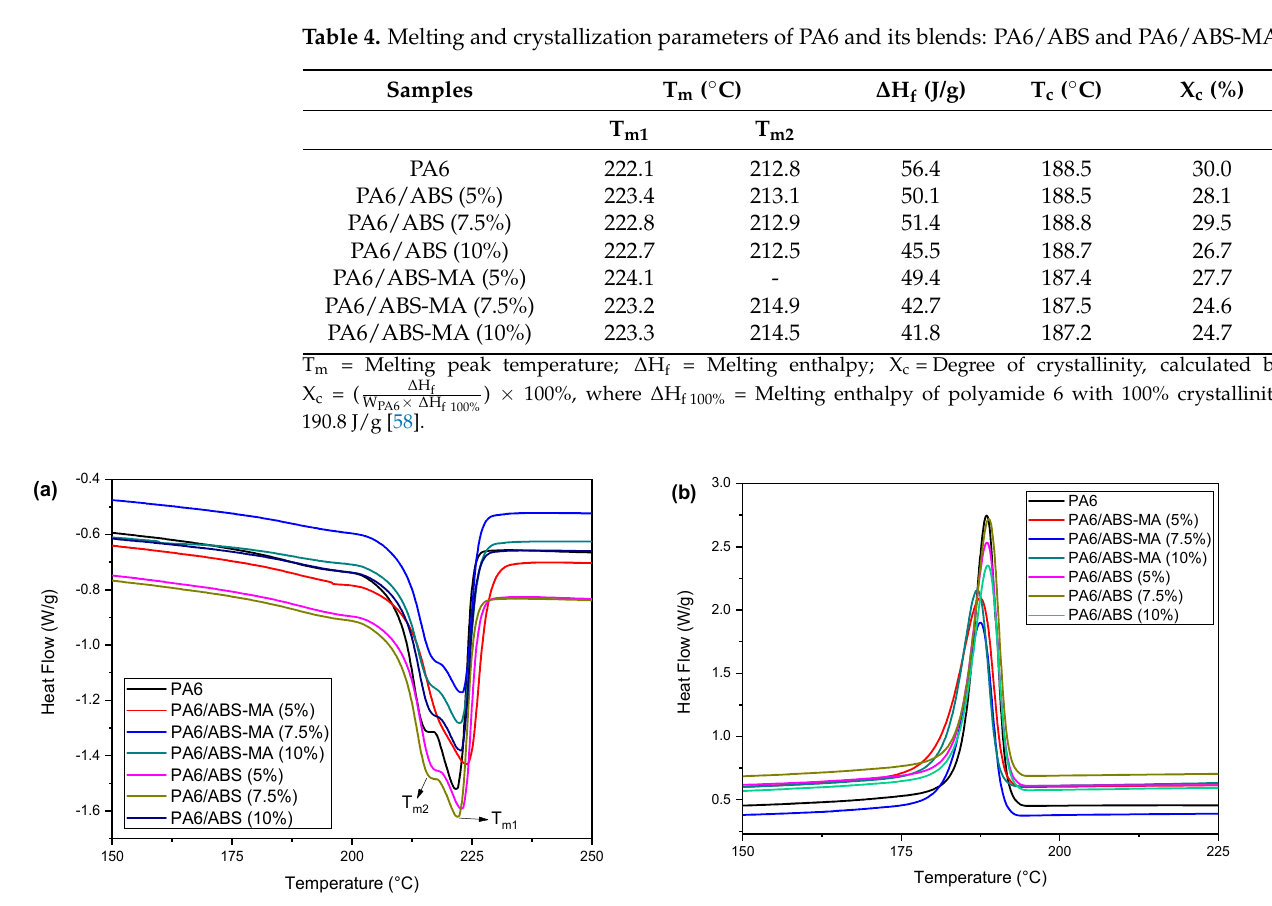
Figure 14. DSC curves of PA6 and its blends: ( a ) Crystalline melting temperature and ( b ) crystallization temperature.